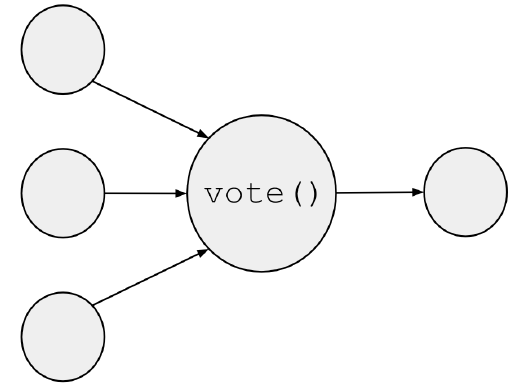
Figure 3. Graphic illustration of vote() function.